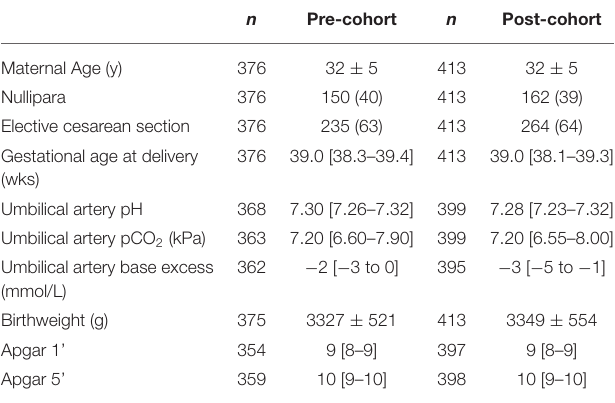
TABLE 1 | Baseline